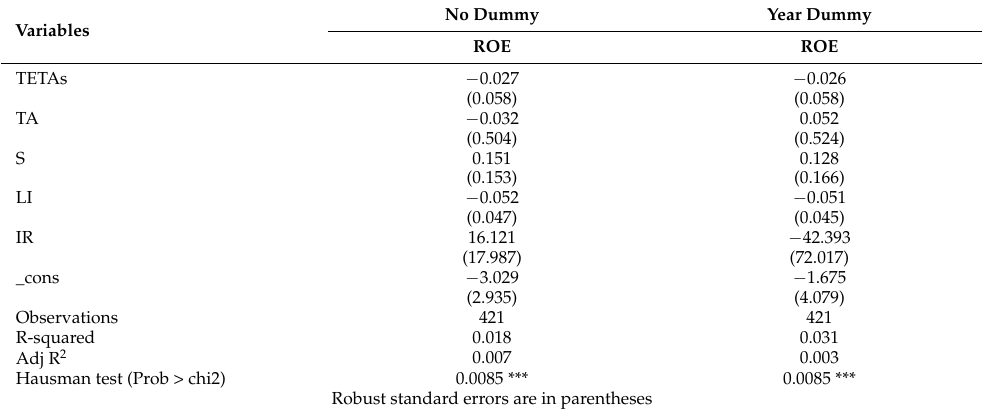
Table 13. Results of the Fixed Effects of TETAs on ROE, as per Panel Data Regression.